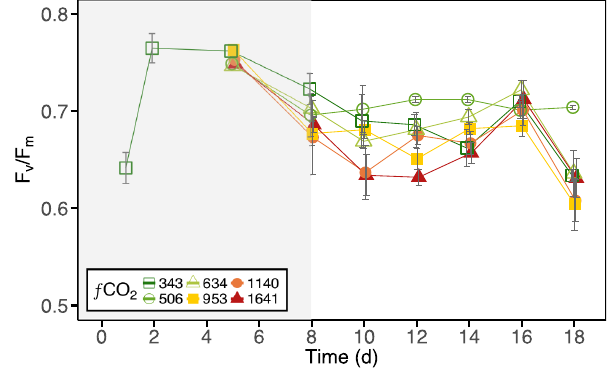
Figure 7. Maximum quantum yield of PSII ( F v /F m ) in each of the minicosm treatments over time. Error bars display 1 standard deviation of pseudoreplicate samples. Grey shading indicates CO 2 and light acclimation